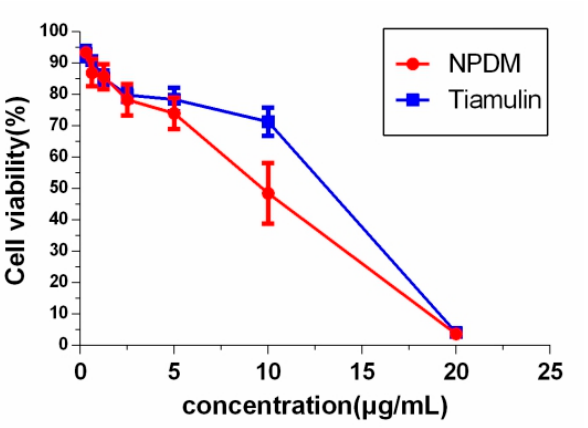
Figure 4. Cytotoxicity of NPDM and tiamulin using BRL-3A cells tested using the MTT methodology.